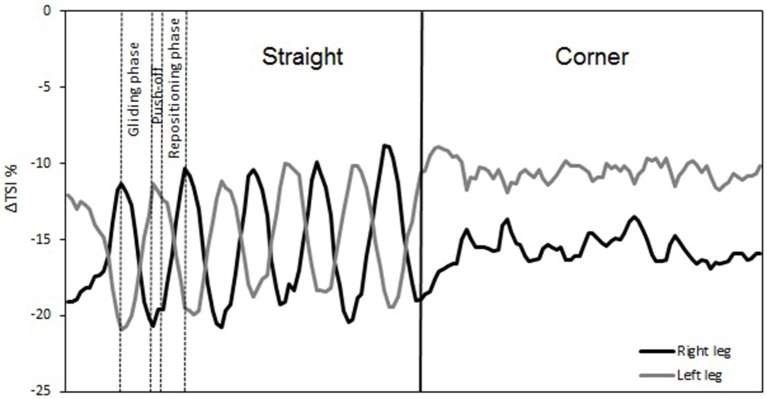
Δ Tissue saturation index (%) in one lap during long-track speed skating. Straights in long-track speed skating are characterized by a repetitive cyclic pattern of three phases per leg: gliding phase, push-off (leg on-ice), and repositioning phase (leg off-ice). These three phases are remarked for a single stroke of the right leg. The corners are characterized by a series of leg crossovers.